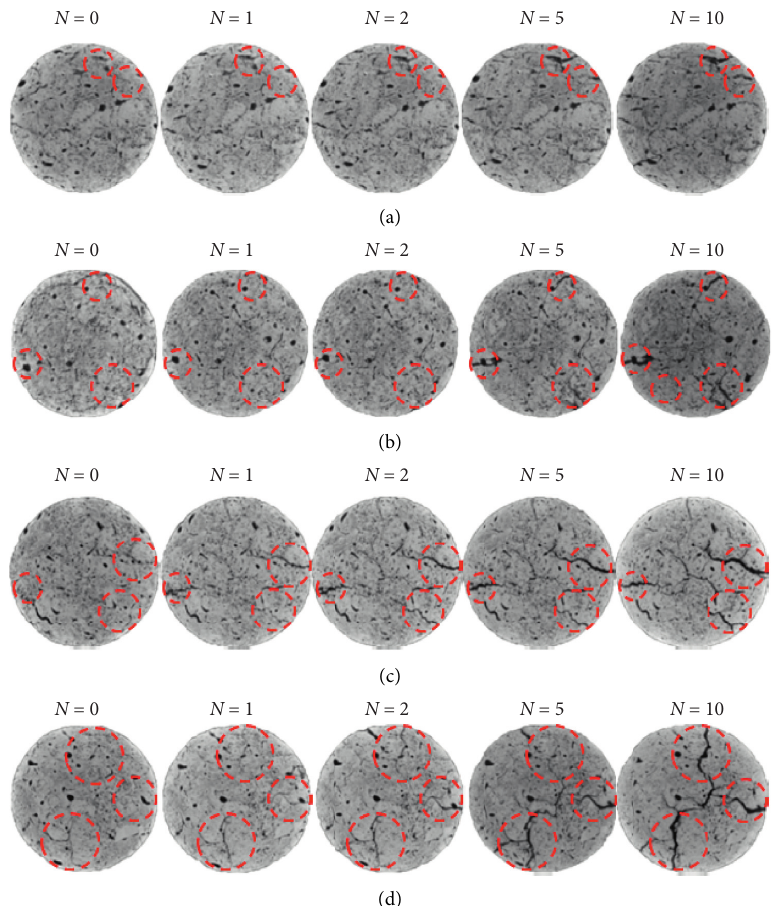
Figure 13: CT scan images of saline intact loess after dry-wet cycles. (a) η � 0.0%, (b) η � 0.5%, (c) η � 1.0%, and (d) η �